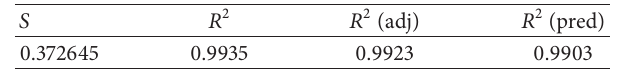
Table 4: Model summary.